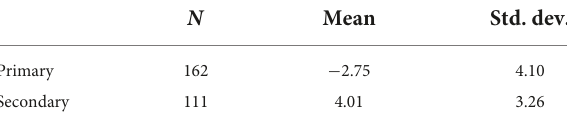
TABLE 2 Mean and standard deviation of location estimates for the primary and secondary performances in the empirical study. N Mean Std.